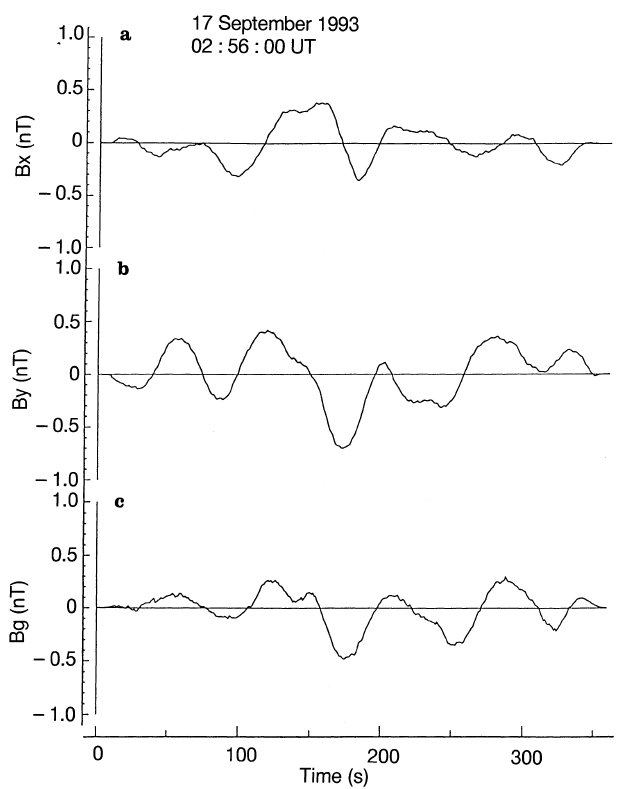
Fig. 1a–c. The signal B-field records on 17 September 1993, 02:56:00– 03:02:00 UT, tapered by a cosine-bell window, a on Freja, x - component (N-S), b on Freja, y -component (E-W), c at Budkov, x